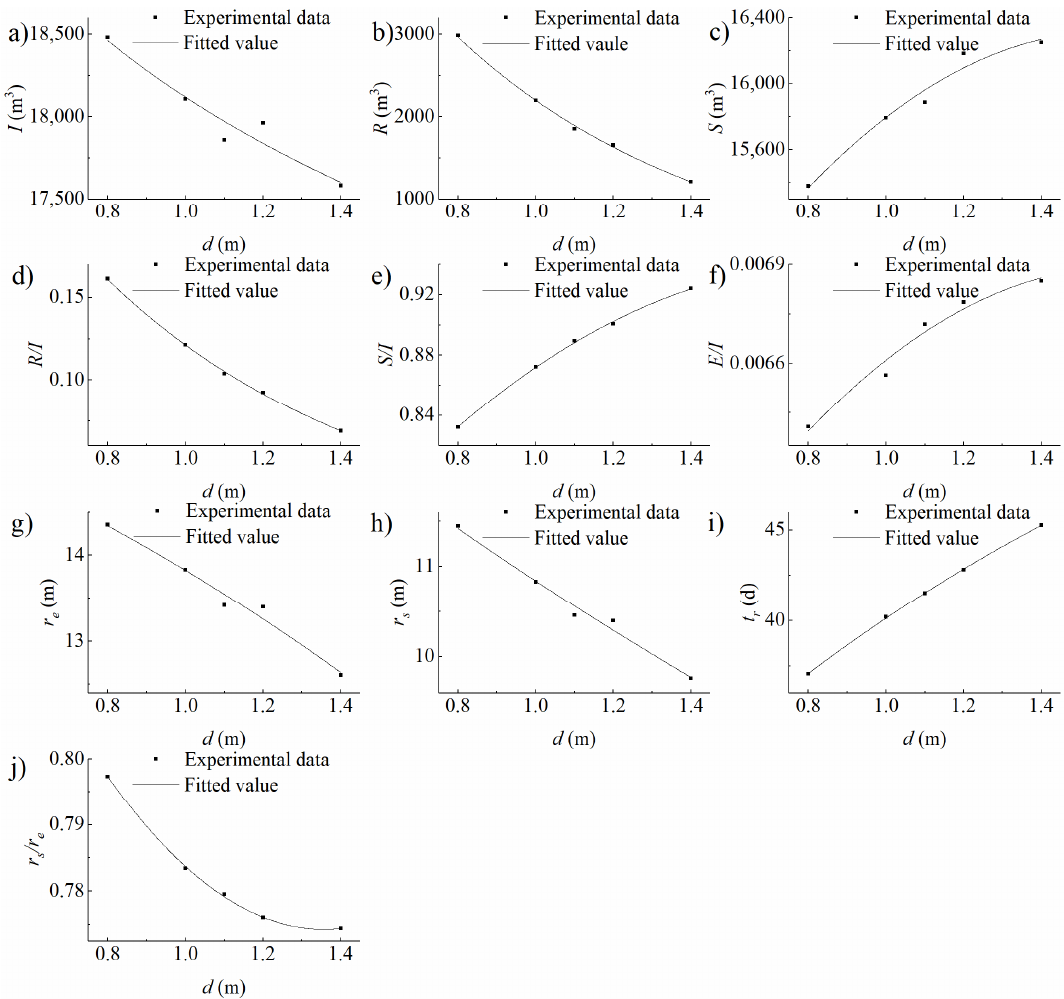
Figure 14. The variations with an increment in d when the depth is 10 m. (( a ) variation of I; ( b ) variation of R; ( c ) variation of S; ( d ) variation of R/I; ( e ) variation of S/I; ( f ) variation of E/I; ( g ) variation of r e ; ( h ) variation of r s ; ( i ) variation of t r ; ( j ) variation of r s /r e .)